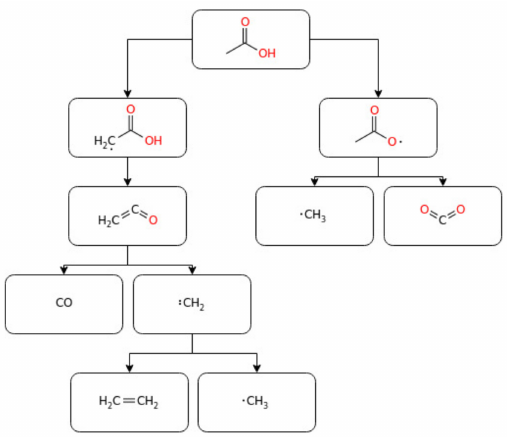
Figure 11. A simplified reaction pathway for acetic acid